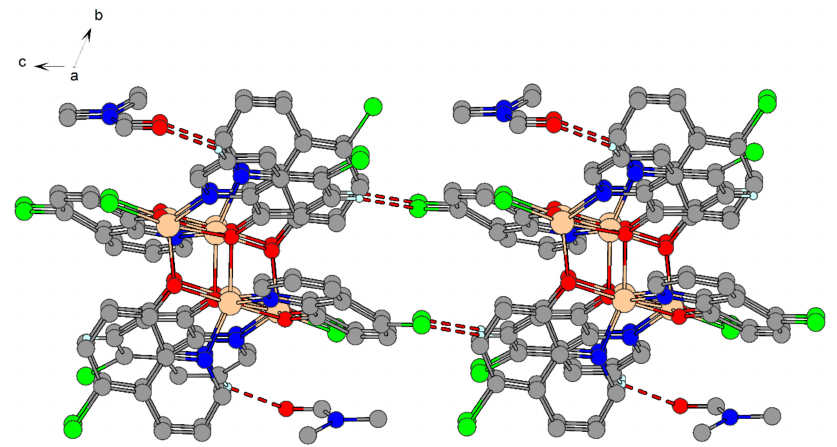
Figure 6. Part of the two-dimensional structure of 1 viewed along the a axis with hydrogen bonds (red dashed lines). Only hydrogen atoms involved in the hydrogen bonds are shown for clarity.